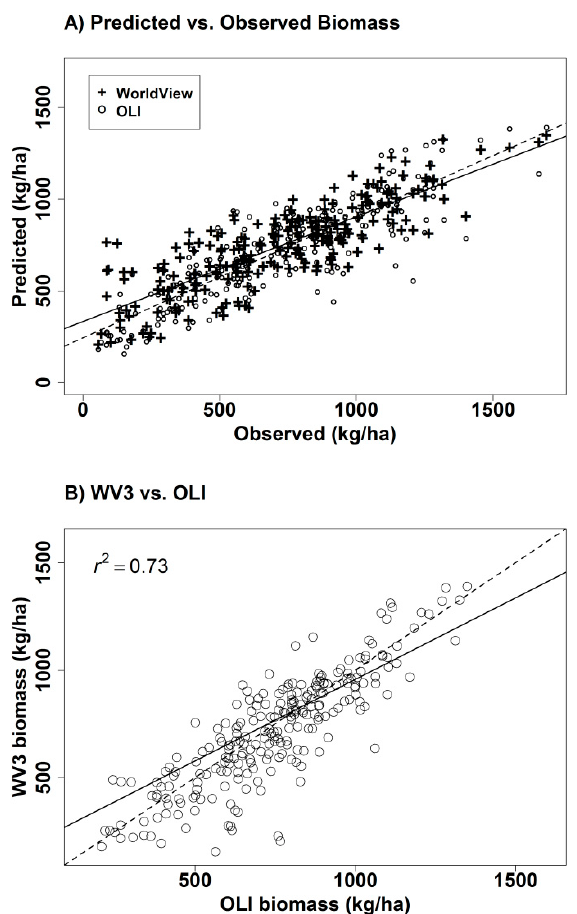
Figure 8. Scatter plots comparing ( A ) predicted and observed plot biomass (kg/ha) from field plots and WV3 ( r 2 = 0.70, solid line) and OLI ( r 2 = 0.74, dashed line) models and ( B ) predicted biomass (fine-fuel) for plot locations by each sensor type and plot ( r 2 = 0.73, solid line). The dashed line in ( B ) is forced though the origin.